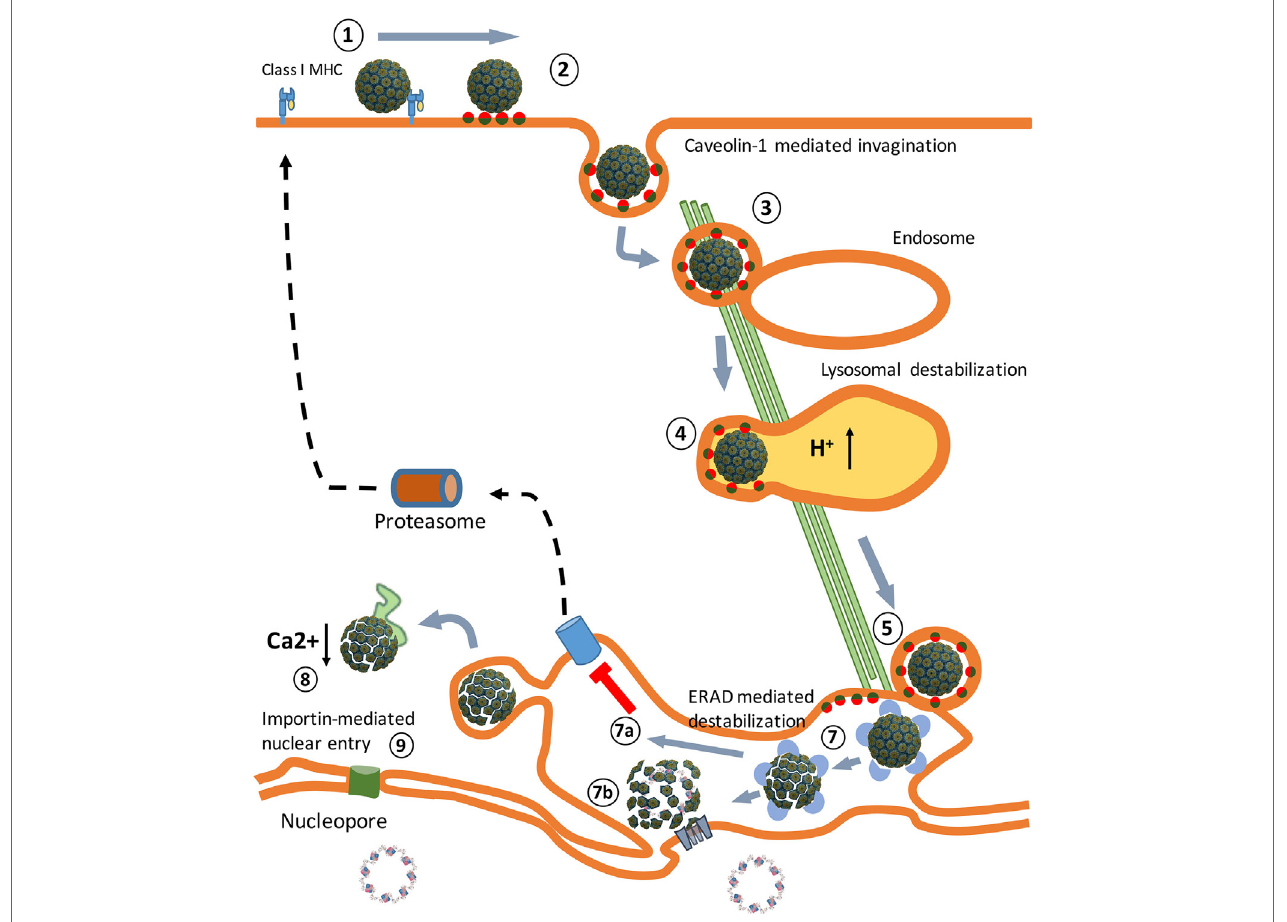
FigURe 1 | An overview of the Simian Virus 40 (SV40) cell entry process. (1) Binding of the virus particles to major histocompatibility class I (MHC-I) molecules that target them to lipid rafts, enriched in GM1 molecules. (2) Release from MHC-I molecules, binding to GM1 molecules, and caveolae vesicle formation. (3) Endosome internalization. (4) Endosome maturation and particle destabilization. (5) Release from endolysosomes and endoplasmic reticulum (ER) trafficking. (6) ER-associated degradation (ERAD)-mediated particle destabilization. (7a) ERAD-mediated cytosol transport. (7b) Viroporin-mediated nuclear entrance. (8) Cytosol destabilization. (9) Nucleopore-mediated nuclear entrance. The SV40 image was created using VMD software (19) PDB ID: 1SVA (20) and is a courtesy of Dr. J.-Y. Sgro, UW- Madison, USA